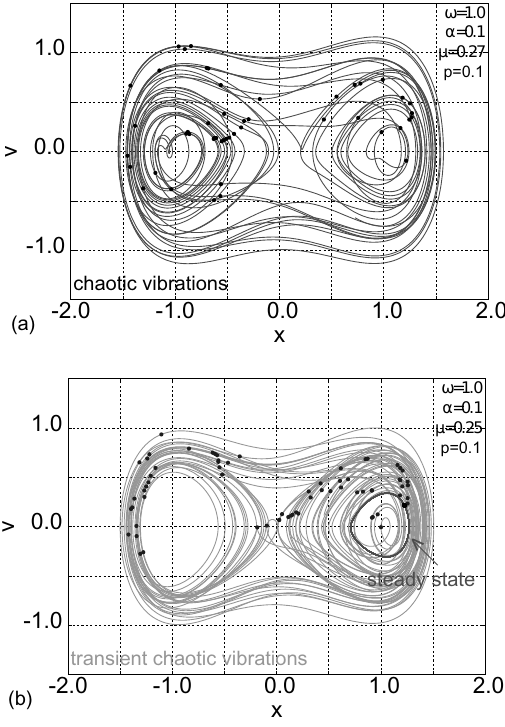
Fig. 5. Phase portraits and Poincare maps for δ = − 1 , γ = 1 and µ = 0 . 27 (Fig. 5(a)), µ = 0 . 25 (Fig.